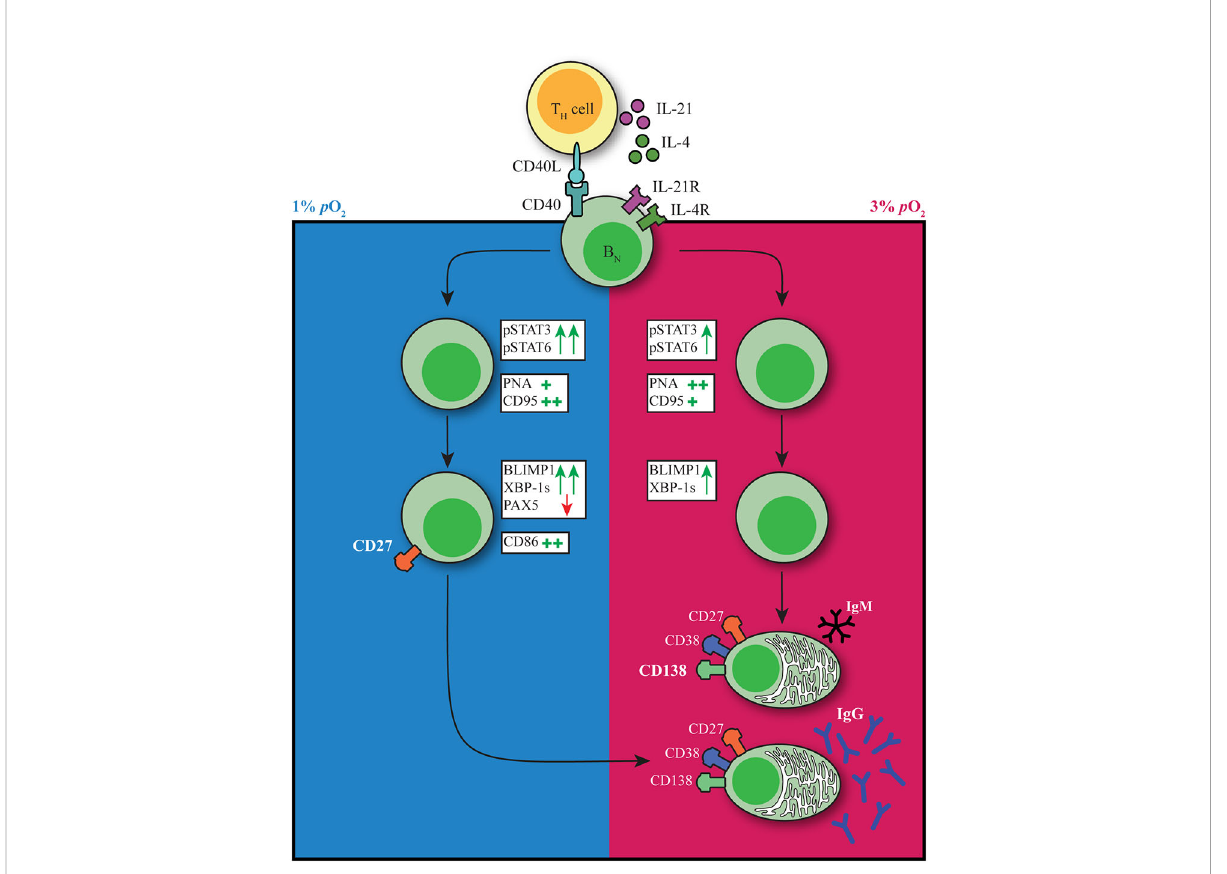
FIGURE 6 pO 2 as a critical driver of B cell differentiation in vitro . Schematic representation of the effect of differential p O 2 on B cell differentiation and underlying signaling